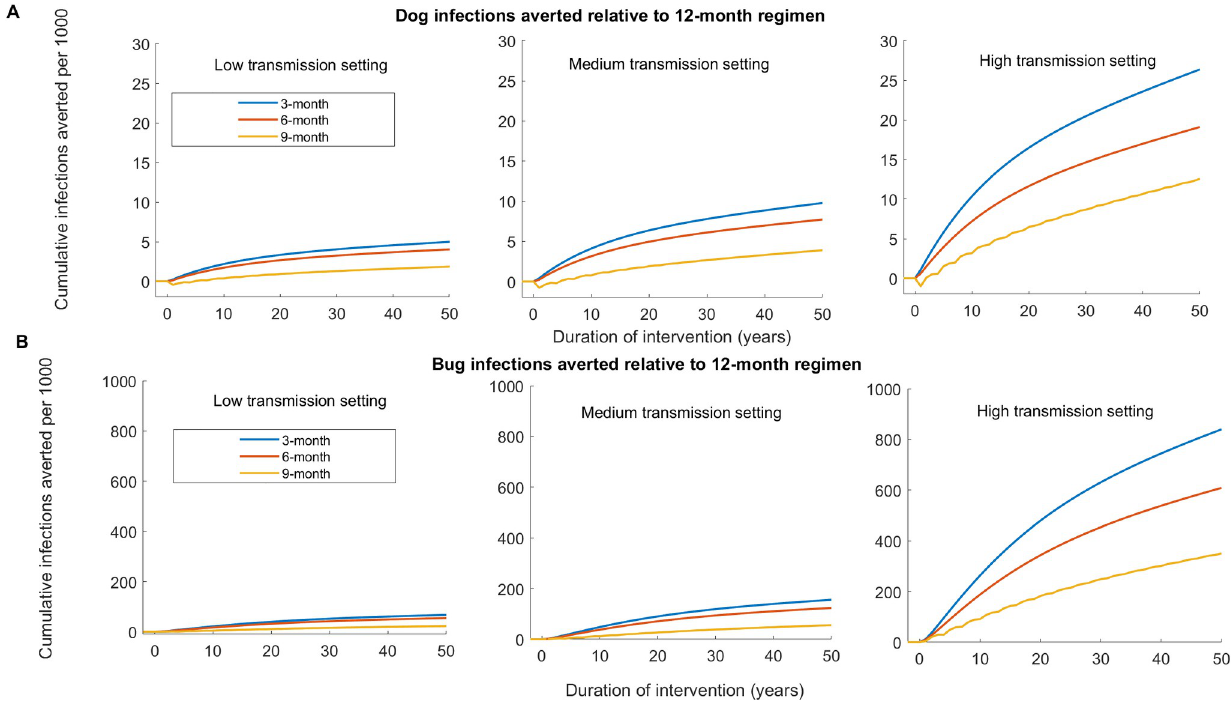
Fig 8. Relative effectiveness of dog treatment regimen for reducing T . cruzi infections among dogs and triatomines compared to a 12-month treatment regimen using Model 3. Effectiveness is computed using the spatially coupled model. (A) Cumulative additional dog infections averted under the 3-month, 6-month, and 9-month regimen relative to the 12-month regimen in the low, medium, and high transmission settings. (B) Cumulative additional triatomine infections averted under the 3-month, 6-month, and 9-month regimen relative to the 12-month regimen in the low, medium, and high transmission settings.